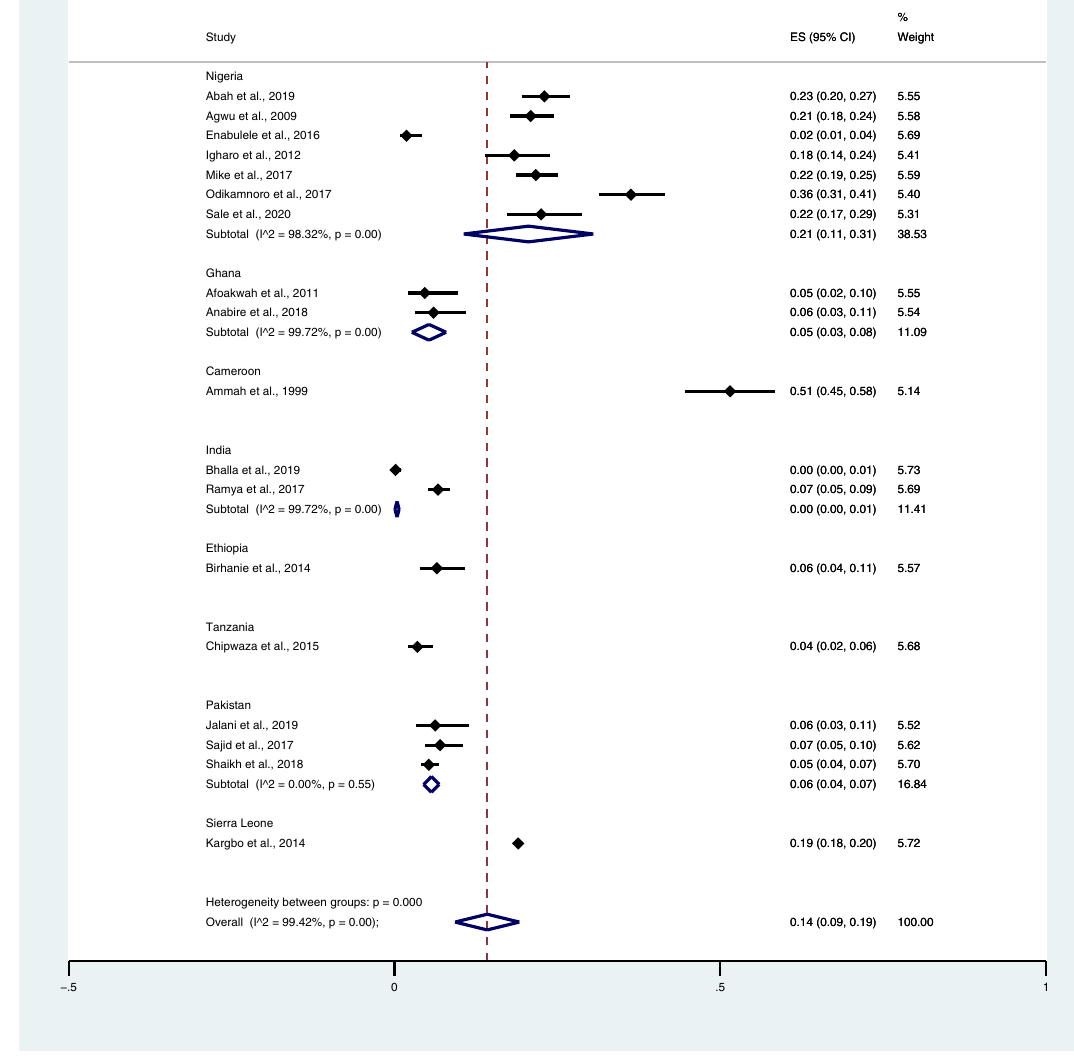
Subgroup analysis of time showed that the prevalence rate of malaria and typhoid co-infections was highest (2%) in 2016 (95% CI 0–1%; I 2 , 72.8%) and 1% in 2009, 2012, 2014, and 2015 and 0% in 2003, 2006, 2013, and 2018 (Fig. 9). Subgroup analysis of time showed that the prevalence rate of malaria and NTS co-infections was highest (1%) in 2014 and 0% in 2012 and 2016 (Fig. 10). Prevalence of typhoidal/NTS infections among patients with malaria. The pooled prevalence rate of typhoidal/NTS infection among malaria patients was estimated from 57 studies 28,35–41,43–48,50–53,55–60,64–66,68–71,73,75–78,81,83,84,86–90,92,93,95,97–99,102–108 . The studies were divided into groups based on diagnostic tests for Salmonella spp. The pooled prevalence rates of typhoidal/NTS infection among patients with malaria were 31% (95% CI 23–39%; I 2 , 99.5%) using the Widal test, 5% (95% CI 0–10%; I 2 , 86.7%) using RDTs, 3% (95% CI 2–3%; I 2 , 86.8%) using blood culture, 2% (95% CI − 1 to 5%; I 2 , 58.7%) using molecular methods, 12% (95% CI 5–19%; I 2 , 86%) using stool cultures, and 27% (95% CI 17–39%) using a combination of blood and stool cultures (Fig. 11). Among the studies using the Widal test for the identification of Salmonella spp. infections, the highest preva- lence rate of typhoidal/NTS among patients with malaria was reported in Cameroon (90%; 95% CI 83–94%) and